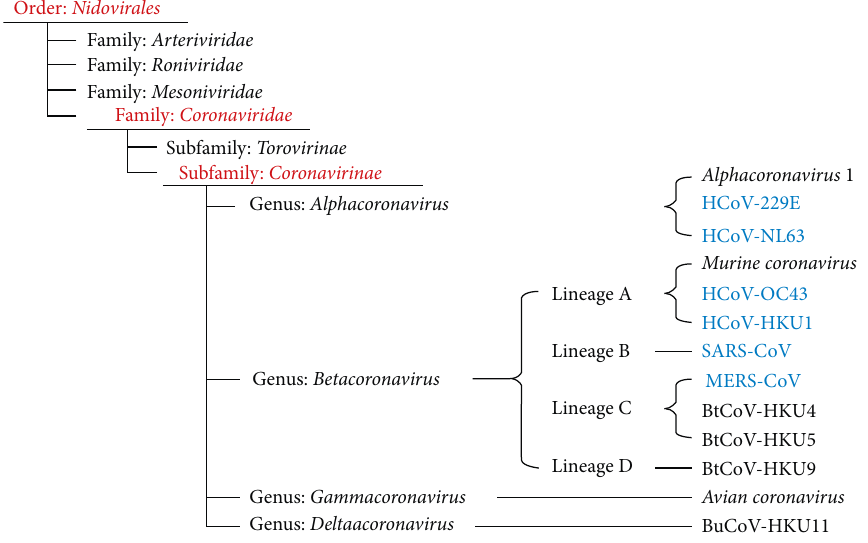
Figure 1: Classification of human CoV and other